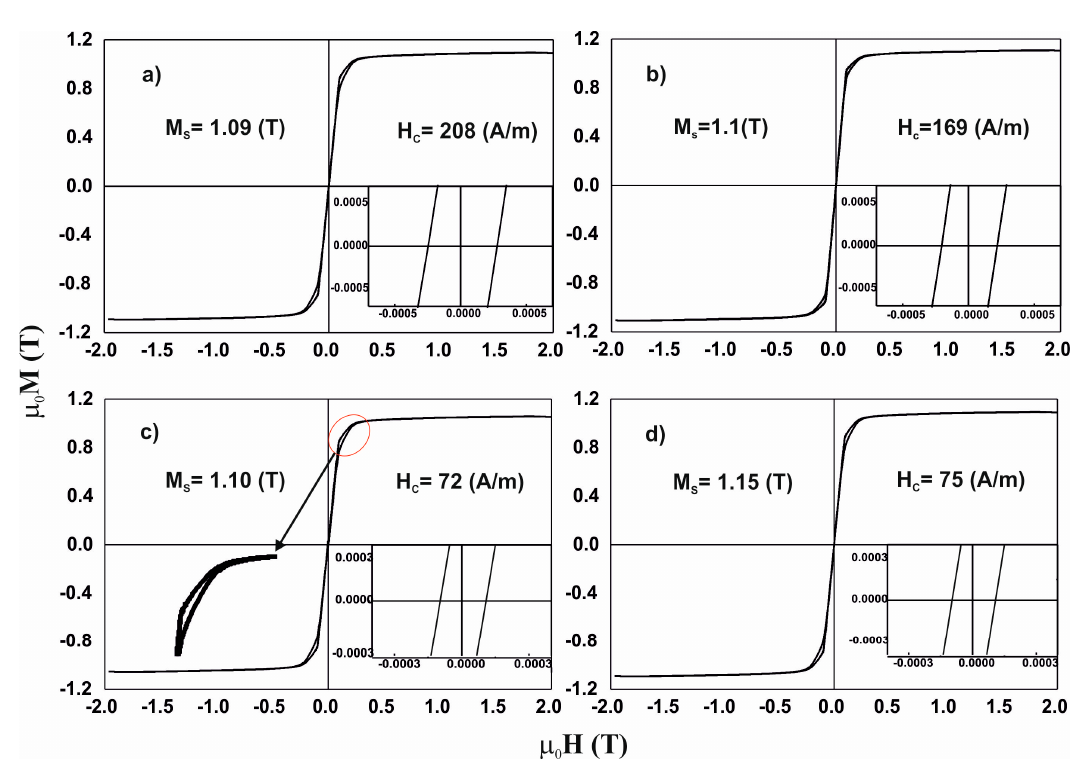
Figure 6. Magnetisation for the alloy Fe 36 Co 36 Y 8 B 20, as a function of: ( a ) (µ 0 H) − 1 , ( b ) (µ 0 H) ×2 , ( c ) (µ 0 H) 1/2 .